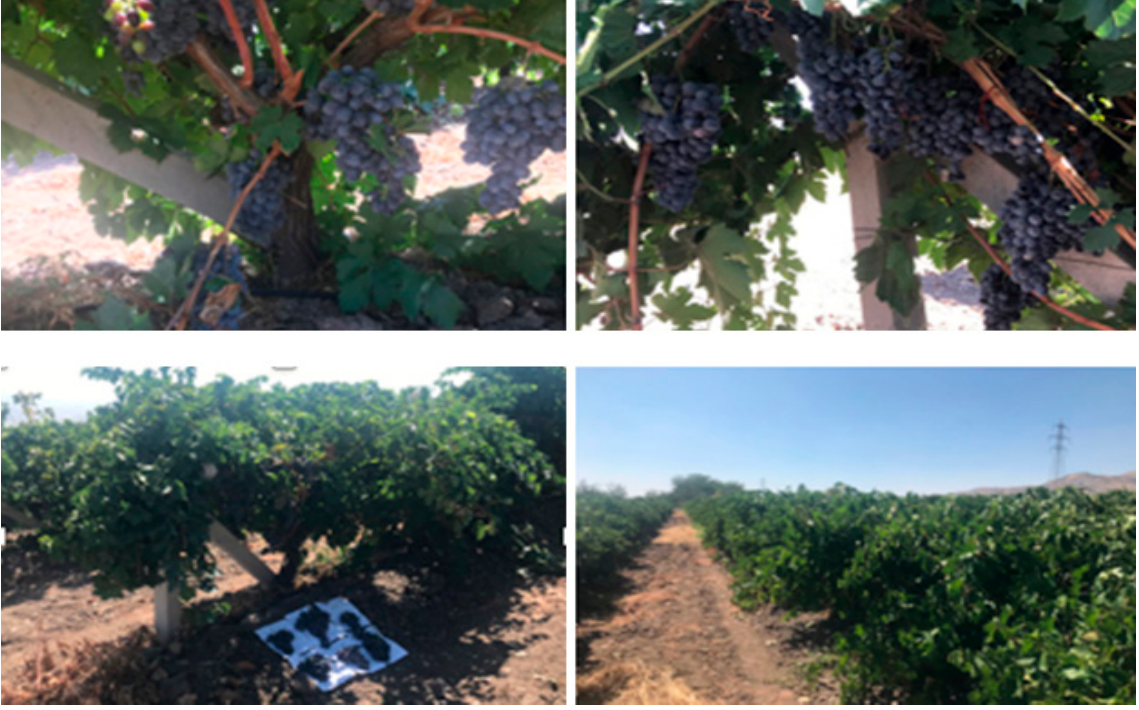
Figure 2. ‘Köhnü’ grapevines in the trellis wire system in Ho ş köy, Elaz ı ğ .